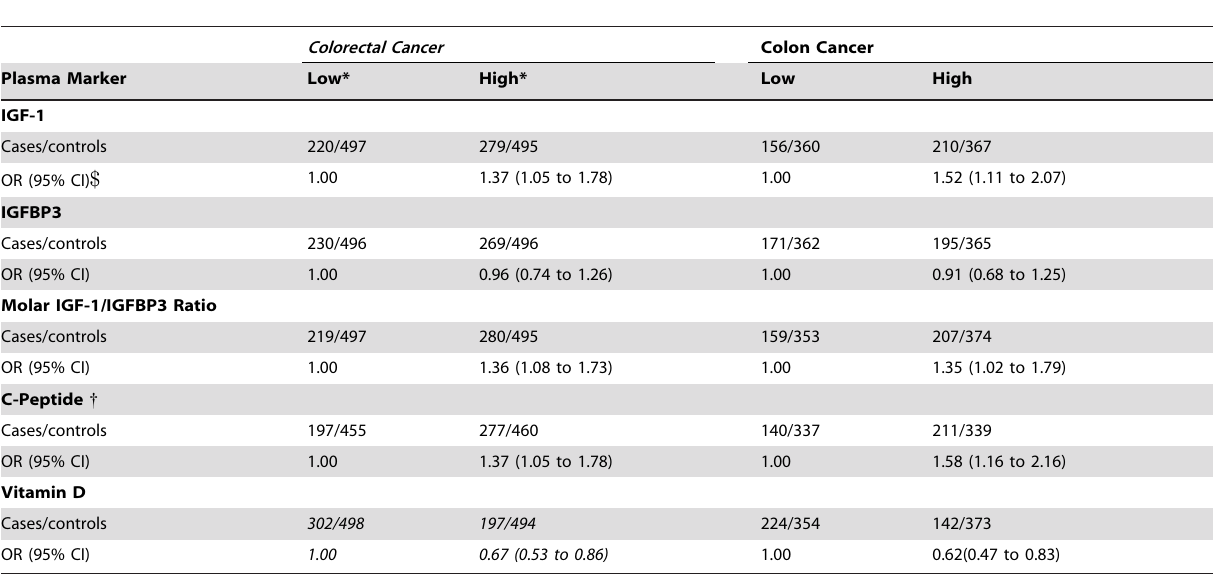
Table 2. Multivariable adjusted odds ratios (OR) of colorectal and colon cancer by median of plasma analyte level, HPFS and NHS